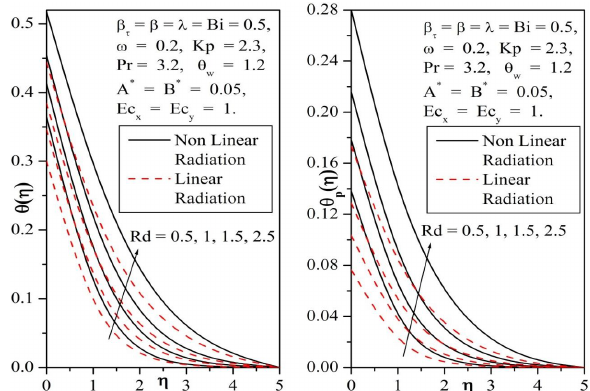
Fig. 18: Dimensionless temperature profiles for different values of Rd .